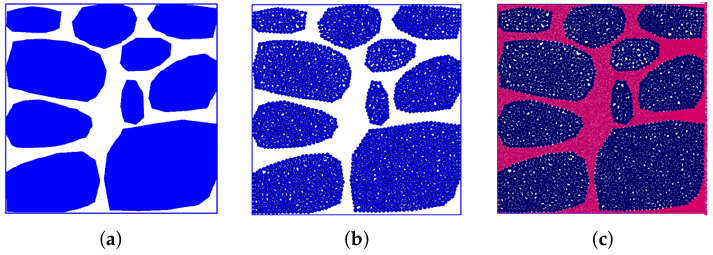
Figure 2. Stone masonry wall 2D-PM model generation procedure. ( a ) Masonry wall; ( b ) Stone unit particle assembly; ( c ) Mortar particle